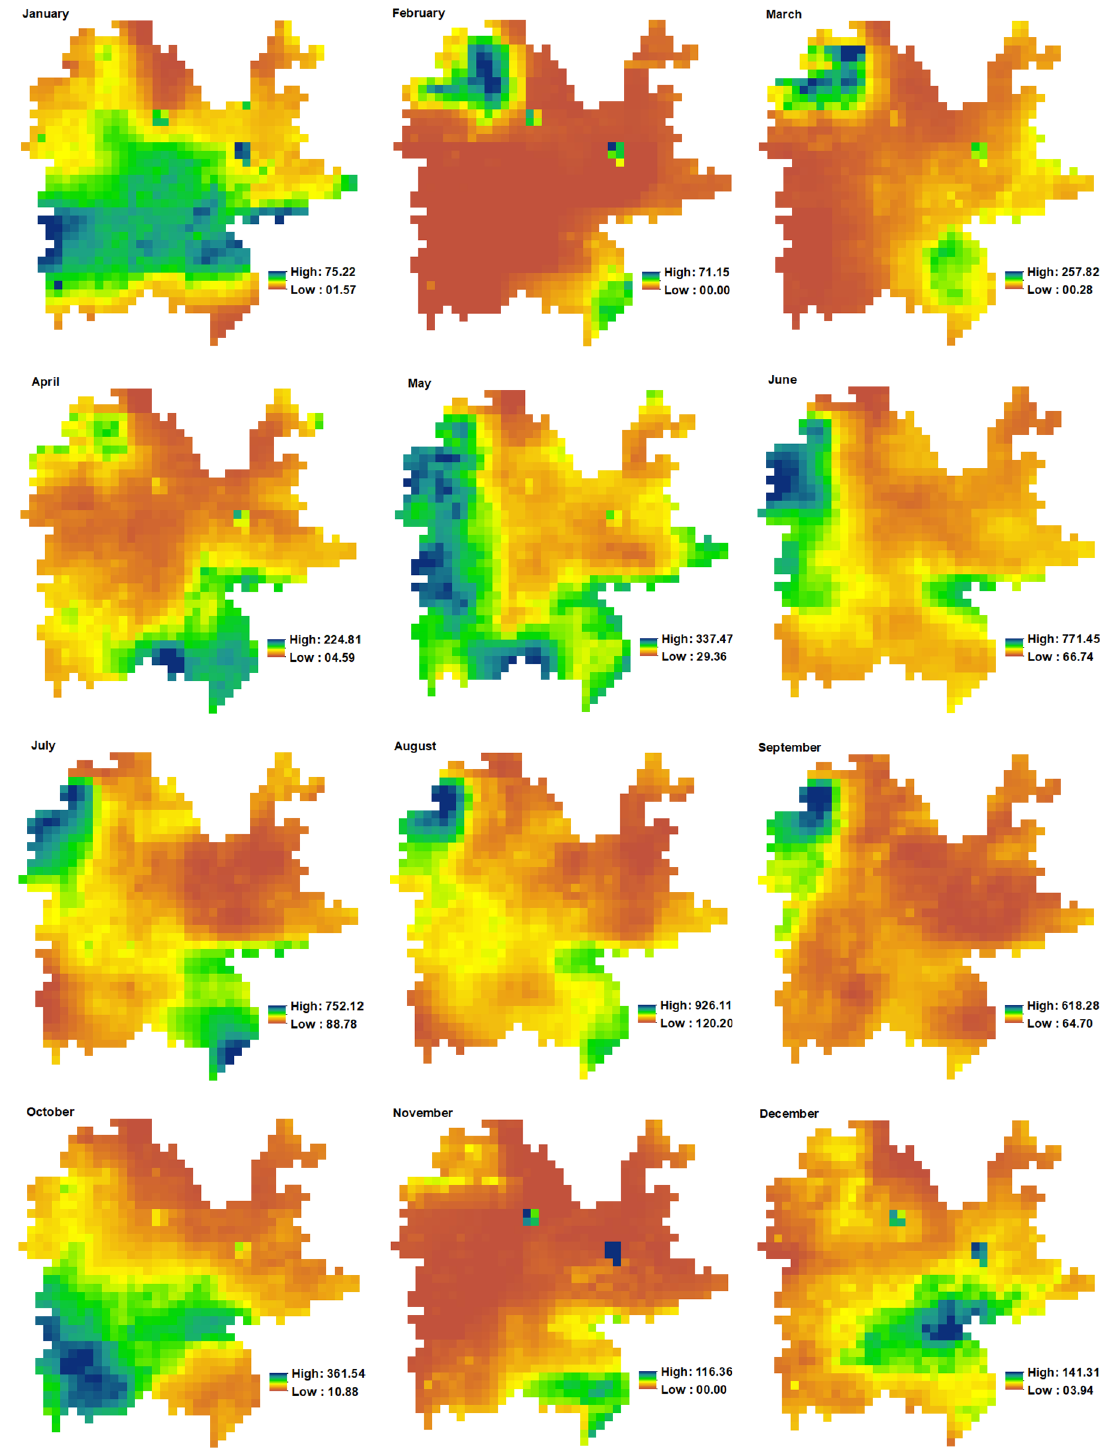
Figure 10. Original monthly TRMM precipitation from January to December 2018.